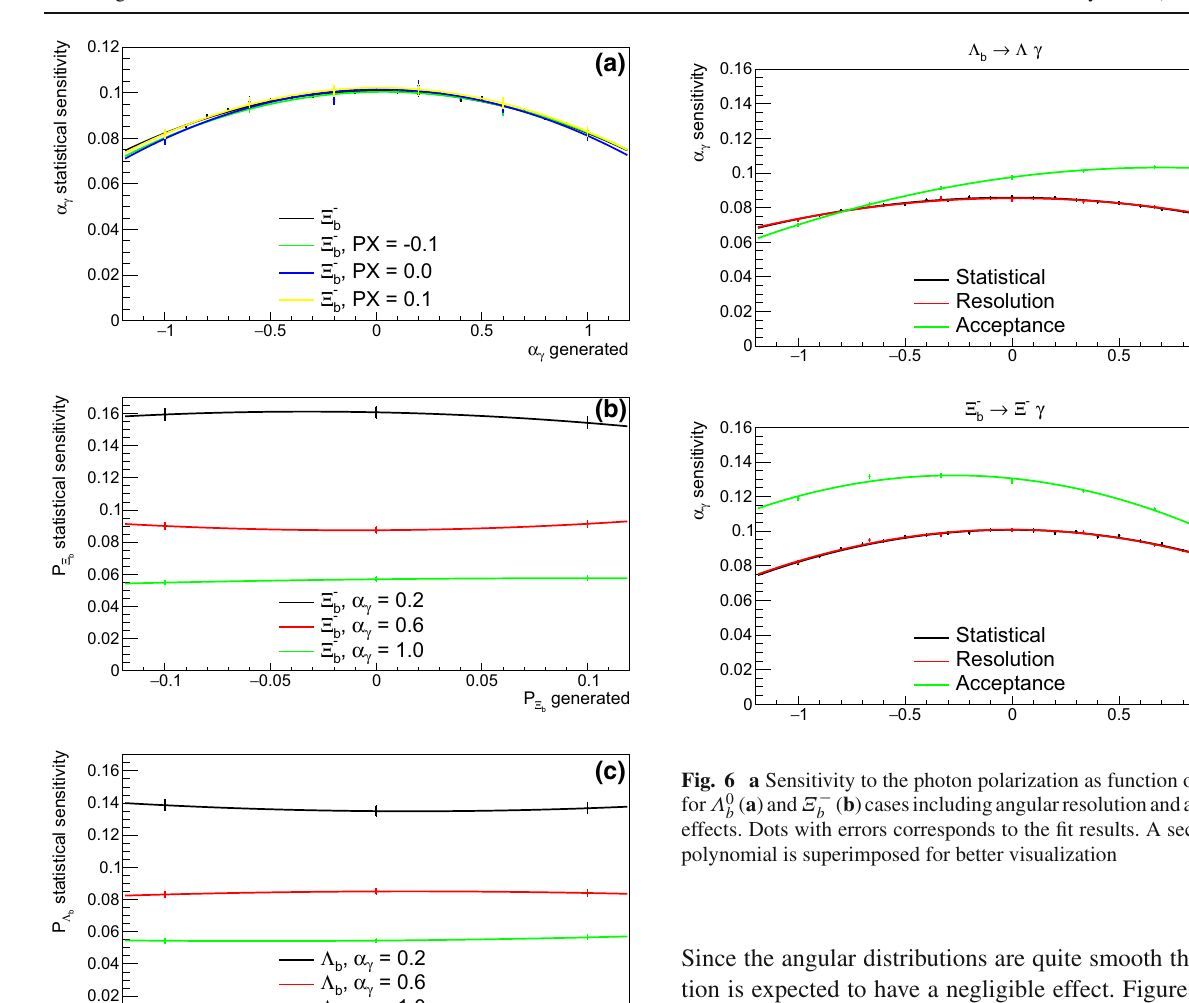
named downstream track category, the angular resolution can be as large as 90 mrad [56]. Since Λ 0 particles have a long lifetime, most of the events are expected in this category. No bias in the mean of the angular resolution is expected. For tracks which are reconstructed including the information of the VELO detector, named long track category, the angular resolution is expected to be better. Monte Carlo simulations are performed using angular resolutions from 30 to 90 mrad.